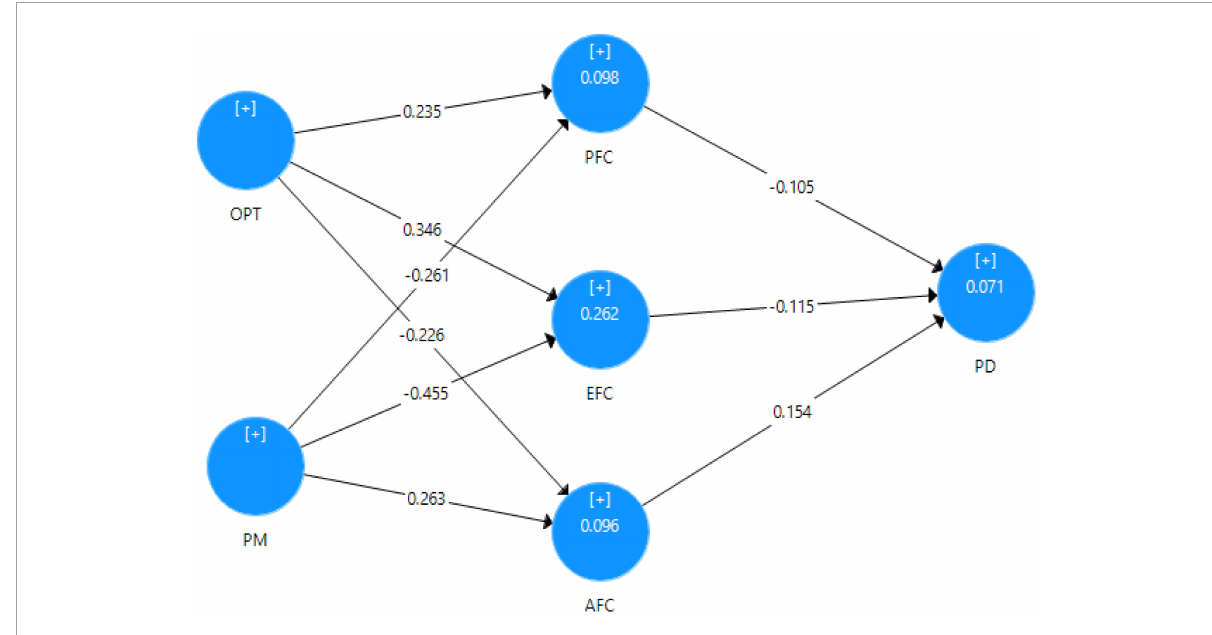
FIGURE1 Structural model.